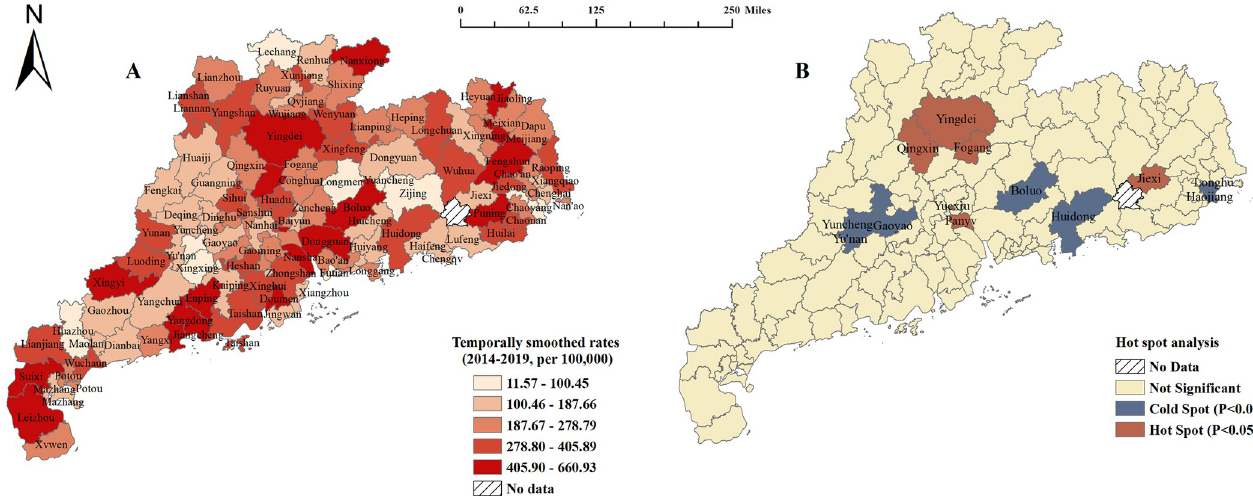
Fig 3. Spatial distribution of preconception syphilis seroprevalence among married individuals aged 21–49 years, 2014–2019. Base layer of the map was downloaded from Resource and Environment Science and Data Center (https://www.resdc.cn/data.aspx?DATAID=201). A: Distribution of syphilis at the county level in Guangdong Province. B: Hot spot analysis result of the county-level syphilis seroprevalence within 122 contiguous counties in Guangdong Province. We calculated temporally smoothed rates as the sum of all seropositive cases divided by the sum of participants over the period 2014–2019, multiplied by 100,000. No data were available for Luhe county and no neighboring counties in Nanao county and they were excluded from the hot spot analysis. Note: The hot spots were determined using Getis-Ord Gi � statistic with first order Queen contiguity weights.